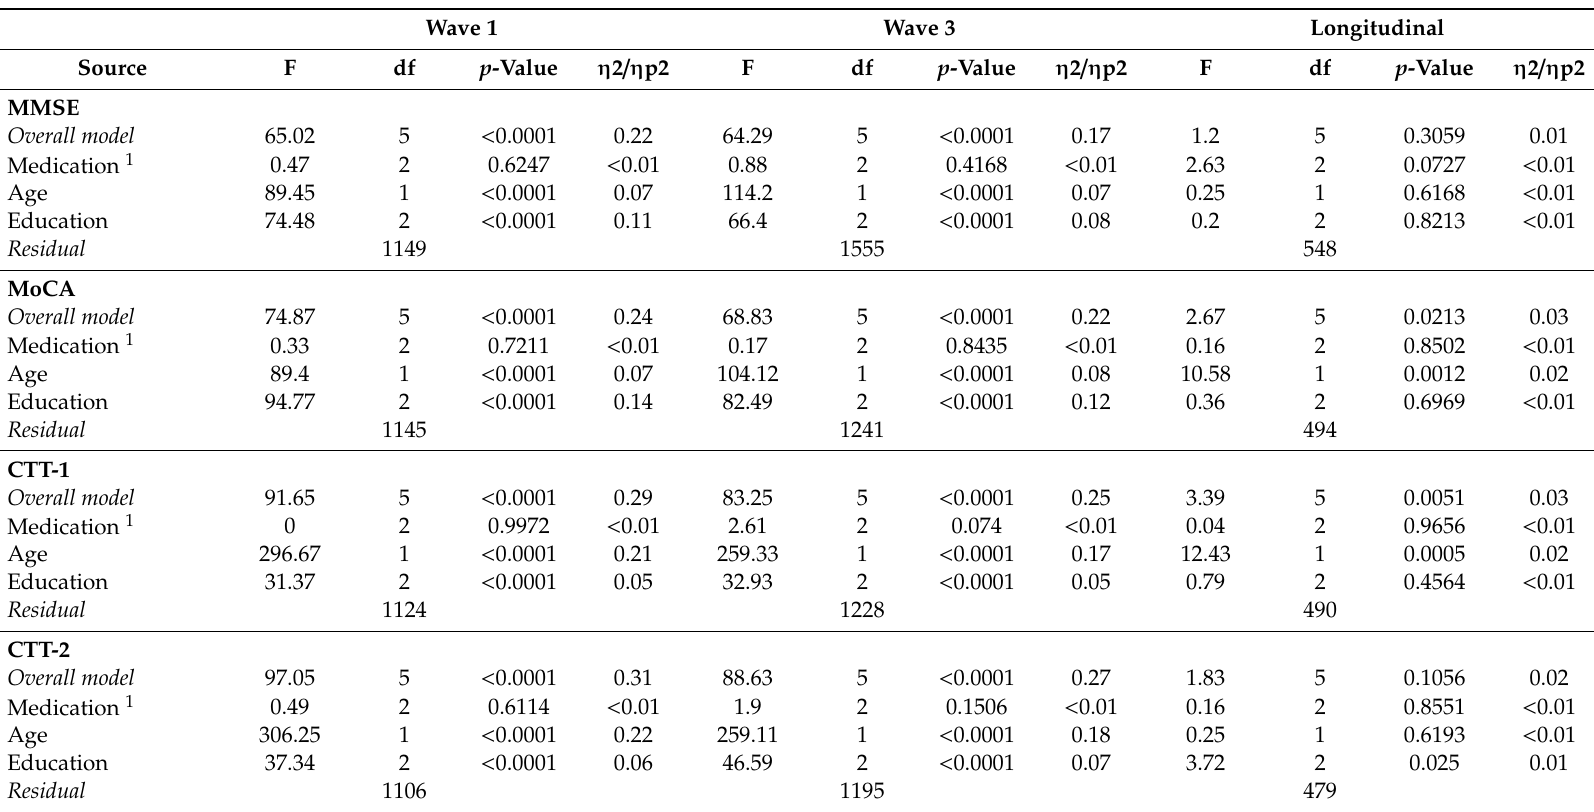
Table 4. ANCOVA results of the e ff ects of medication categories on di ff erent cognitive measures controlling for age and education (partial model). Wave